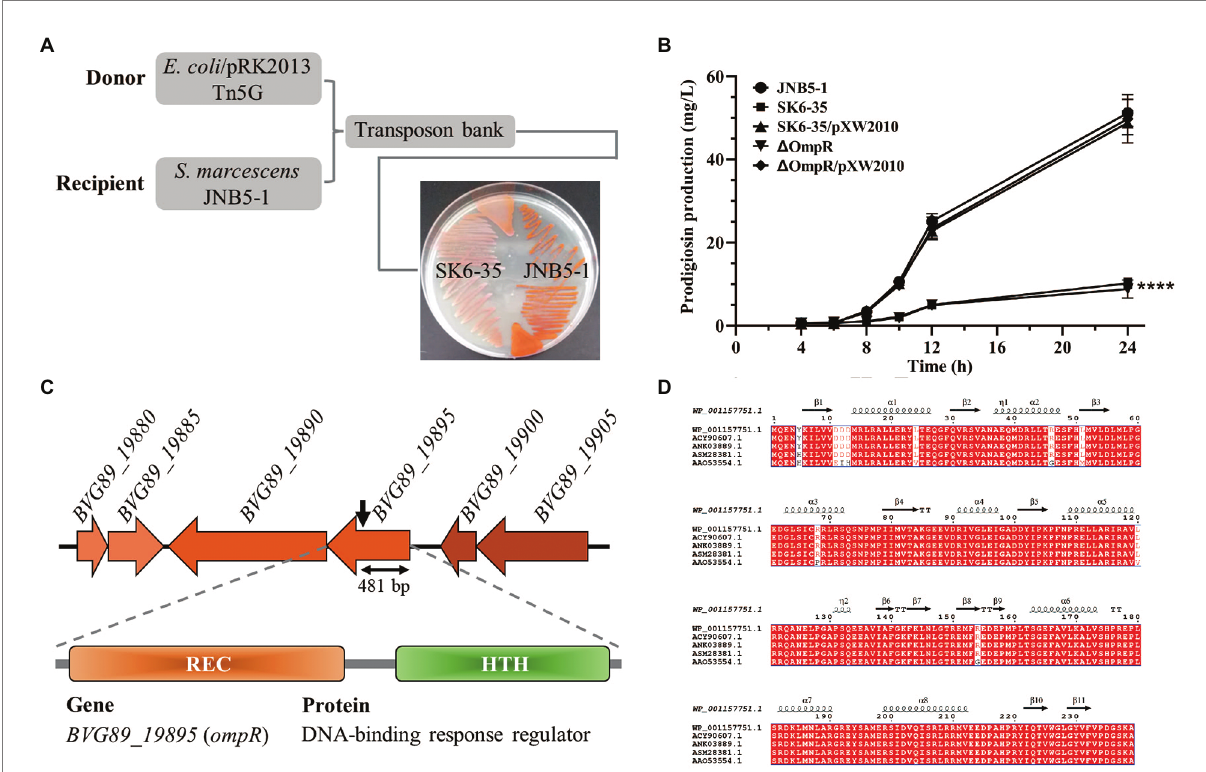
FIGURE 1 OmpR is a prodigiosin synthesis activator in strain JNB5-1. (A) A prodigiosin producing mutant SK6-35 was identified by Tn5G transposon insertion mutation. (B) Prodigiosin production analysis of strains JNB5-1, SK6-35, SK6-35/pXW2010, Δ PsrA, and Δ PsrA/pXW2010. JNB5-1 is a wild-type Serratia marcescens , SK6-35 is an ompR disrupted mutant, Δ OmpR is an ompR deleted mutant, SK6-35/pXW2010 and Δ OmpR/pXW2010 are ompR complemented strains. The experiment was performed independently three times. Error bars indicate standard deviations. One-way analysis of variance (ANOVA) was used to examine the mean differences between the data groups. **** p < 0.001. (C) Genetic loci identified in mutant SK6-35. (Upper) Genetic map of the disrupted gene BVG89_19895 ( ompR ) and its surrounding genes. The Tn5G insertion site is indicated by black arrow points. (Middle) The domain organization of the BVG90_19895 protein. (Lower) BVG90_19895 is a DNA-binding response regulator. (D) Multiple sequence alignment of OmpR homologies. The sequences used for analysis were OmpR homologies from S. marcescens (ASM28381.1), E. coli (ANK03889.1), Klebsiella pneumoniae (WP_001157751.1), Salmonella enterica subsp. enterica serovar Typhimurium (ACY90607.1), and Yersinia enterocolitica